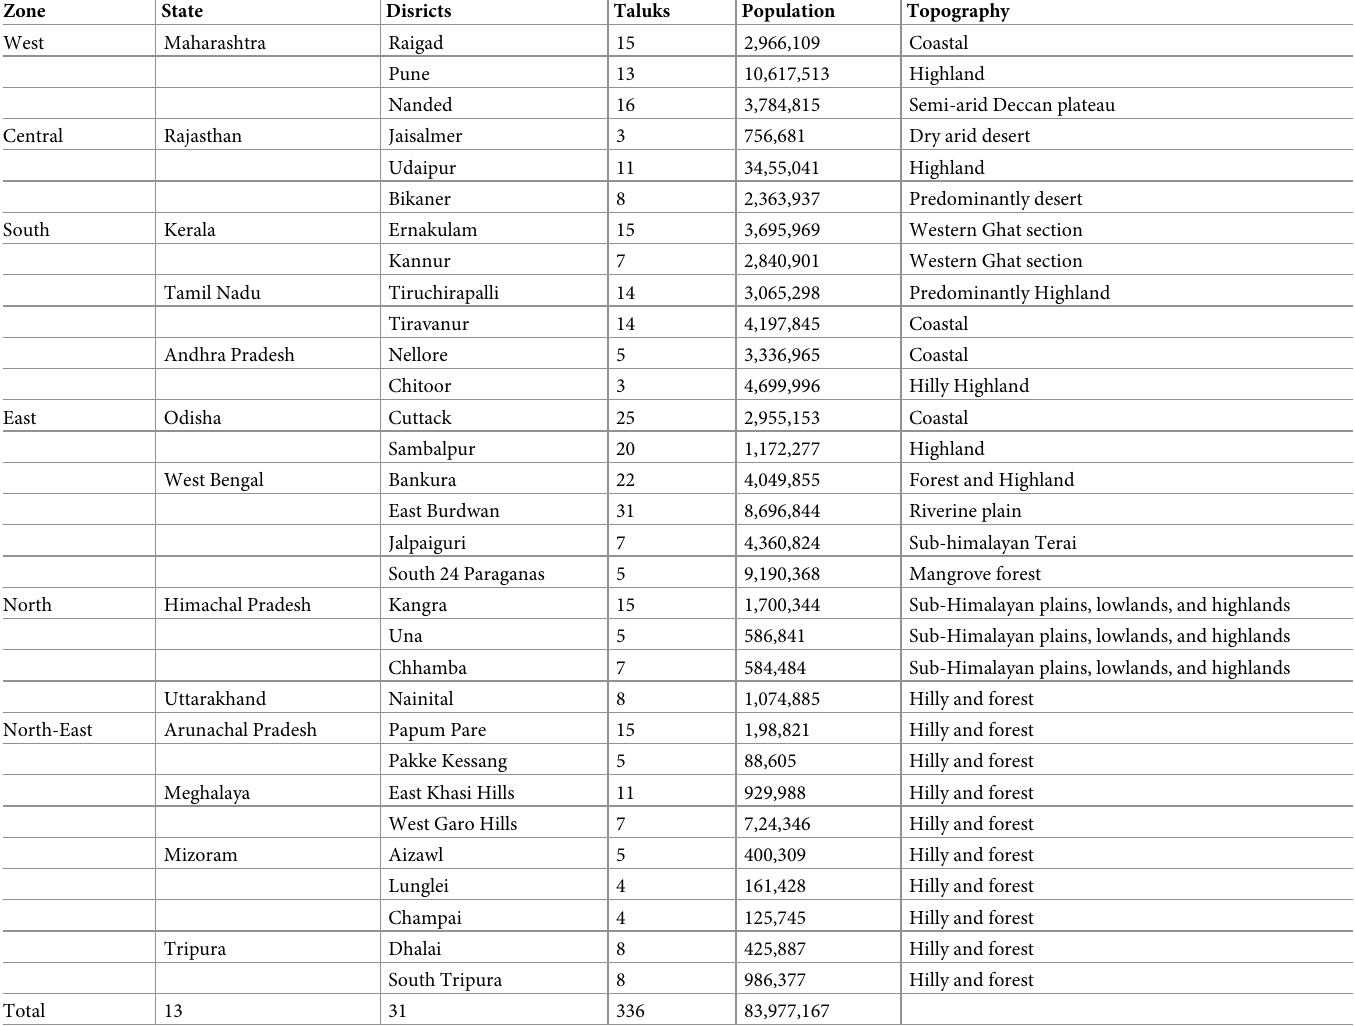
Table 1. Included districts, population and